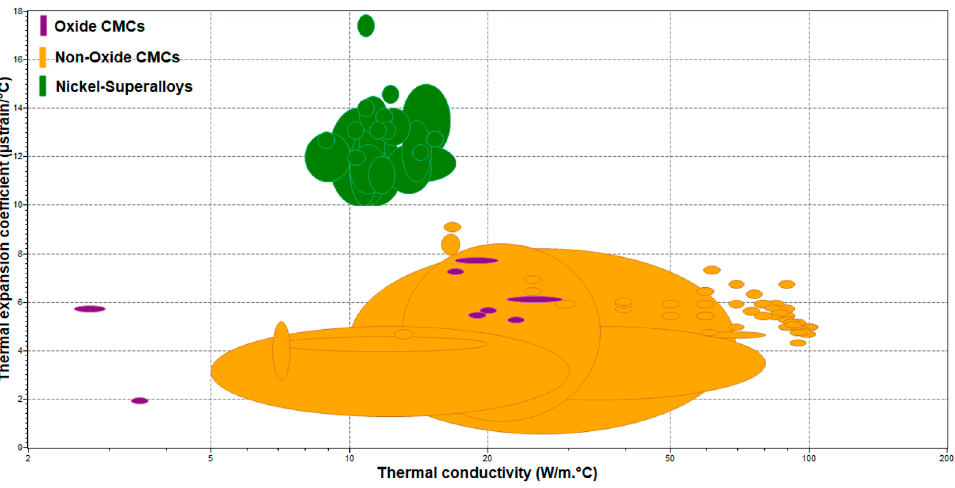
Figure 11. Comparison of thermal expansion coefficient vs. thermal conductivity of the available CMCs.